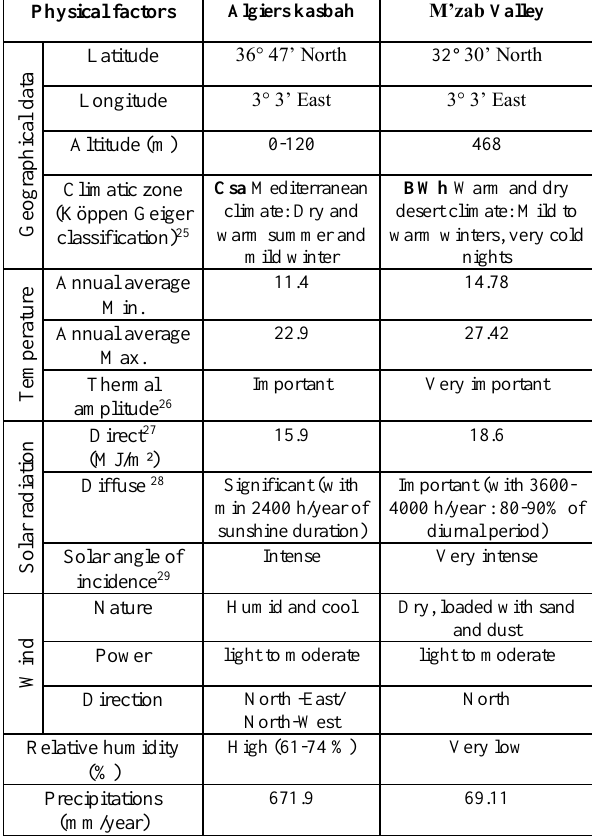
Table 1. Physical factors of the geo-climatic environment of the Algiers Kasbah and the M'zab